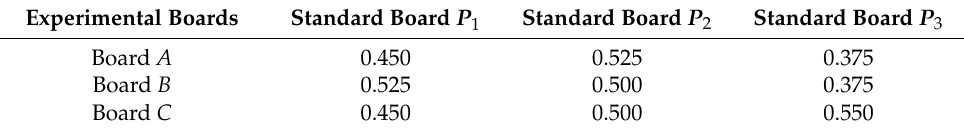
Table 7. The dose-approximation values between the experimental boards and standard boards. Experimental